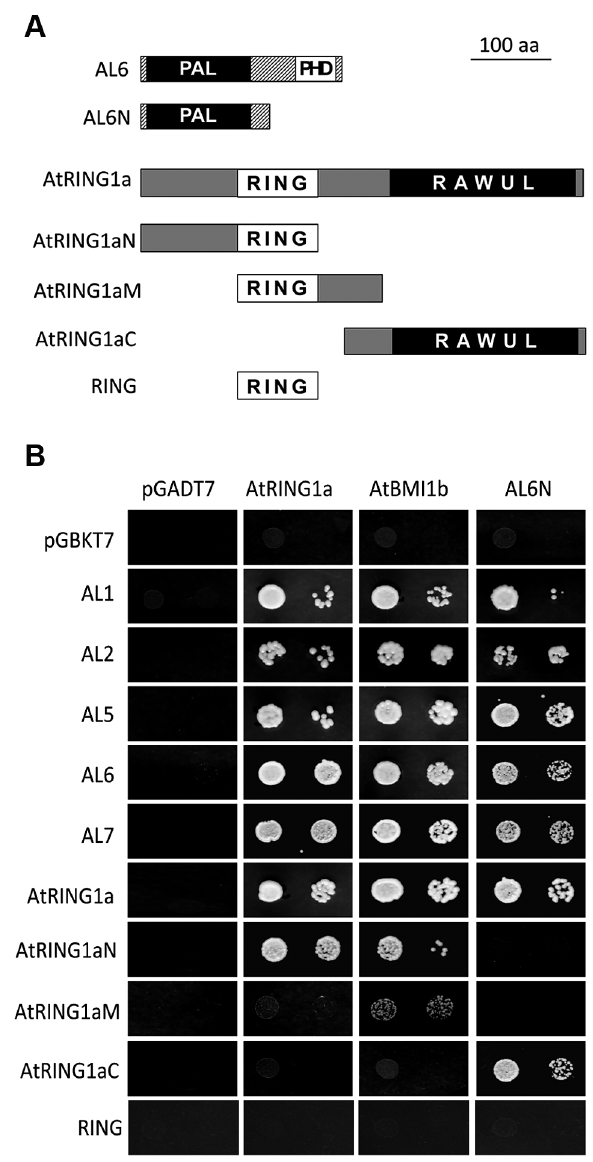
Figure 1. Interactions of ALs and PRC1 ring-finger proteins in yeast two-hybrid assay. (A) Schematic representation of full-length and truncated AtRING1a and AL6 proteins. The conserved domains PAL, PHD, RING and RAWUL are indicated. (B) Yeast two-hybrid assays. Yeast cultures co-expressing the indicated protein combinations from pGADT7 and pGBKT7 were plated as a 1:10 dilution from left to right onto SD-LTA selective media. Growth of yeast cells indicates positive protein-protein